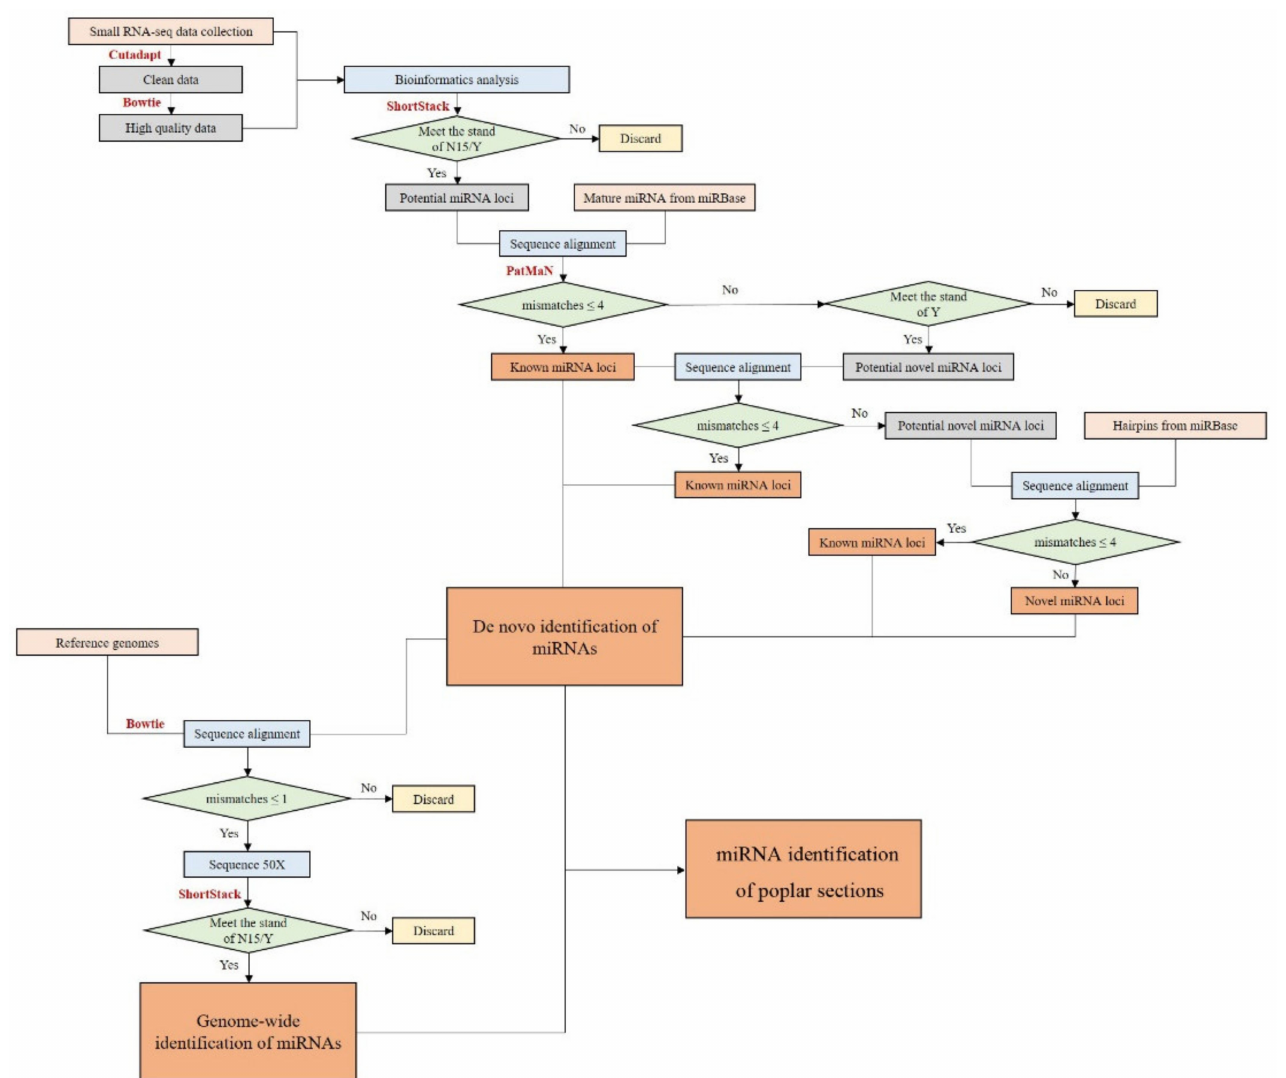
Figure 1. Flow chart of miRNA loci